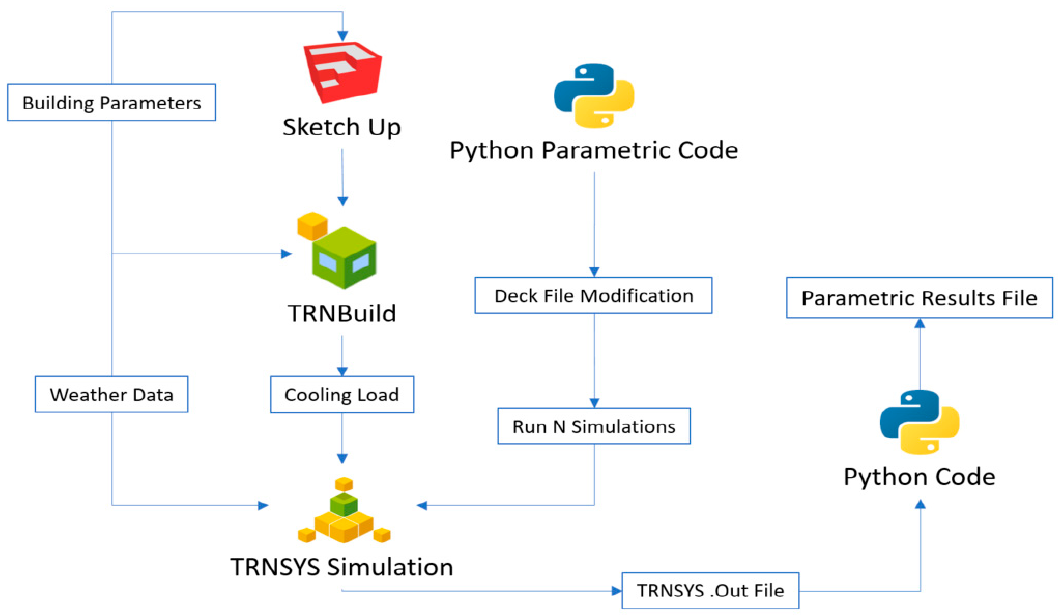
Energies 2020 , 13 , x FOR PEER REVIEW Figure 2. Simulation and parametric study methodology. Figure 2. Simulation and parametric study methodology.